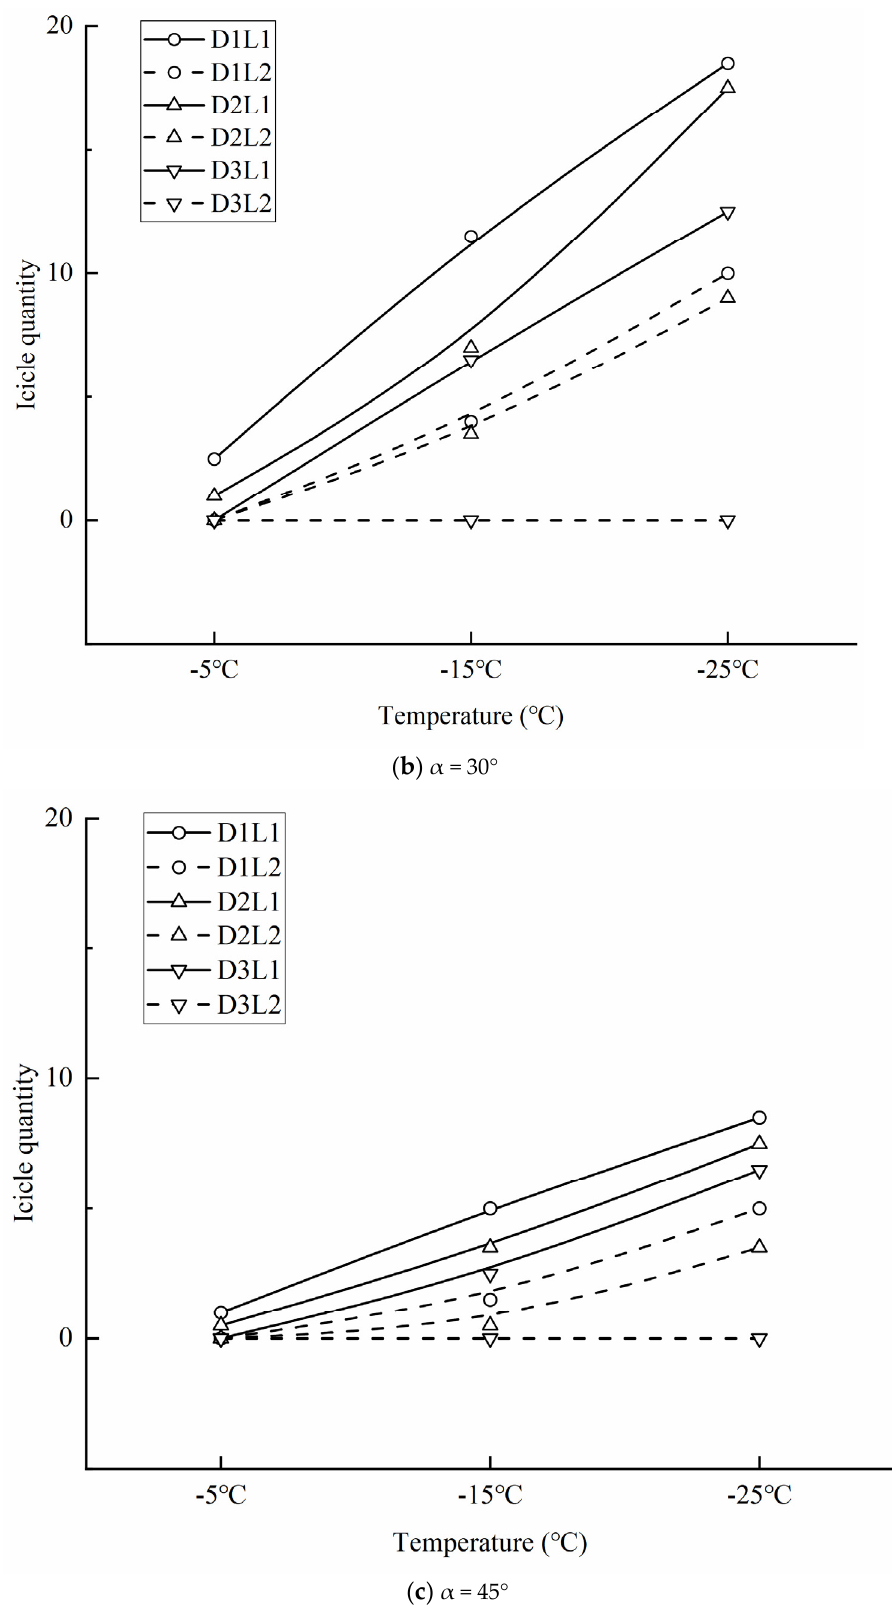
Figure 8. ( a – c ) In fl uence law of temperature on icicles quantity (per meter). In the icing phenomenon, the water fi lm often develops laterally in the plane after accumulation. When the ice rib is formed, water droplets gather into the water fl ow and gradually freeze during the fl ow process. In this process, the width and thickness of water droplets increase continuously, forming a cylindrical ice structure distributed on both sides of the stay cable in the shape of ribs. The size of the ice ribs formed in the freezing process of the stay cable is roughly the same, and most of the ice ribs are formed on the windward side [26]. When the ambient temperature is − 25 °C, the ice rib of the cable will further develop into banded ice at the bo tt om, which is facilitated by low temperature and appropriate inclination angle conditions. The width of each ice rib in Figure 9a–d represents the width distance from the root of the ice rib, i.e., where the ice rib grows, with the zero of the vertical coordinate corre- sponding to the case where no ice rib appears and the horizontal coordinate is related to di ff erent ambient temperatures. The width of the ice ribs formed gradually increases with decreasing temperature at a given inclination angle, with the rate of increase ranging from 50.6% to 170%. It can be seen that lowering the temperature promotes the growth of ice ribs. This is because the release of latent heat in the dynamic freezing process will increase the surrounding surface temperature [22]. Under the same conditions, the lower ambient temperature will take away this part of heat faster and accelerate the growth of the ice rib of the stay cable.